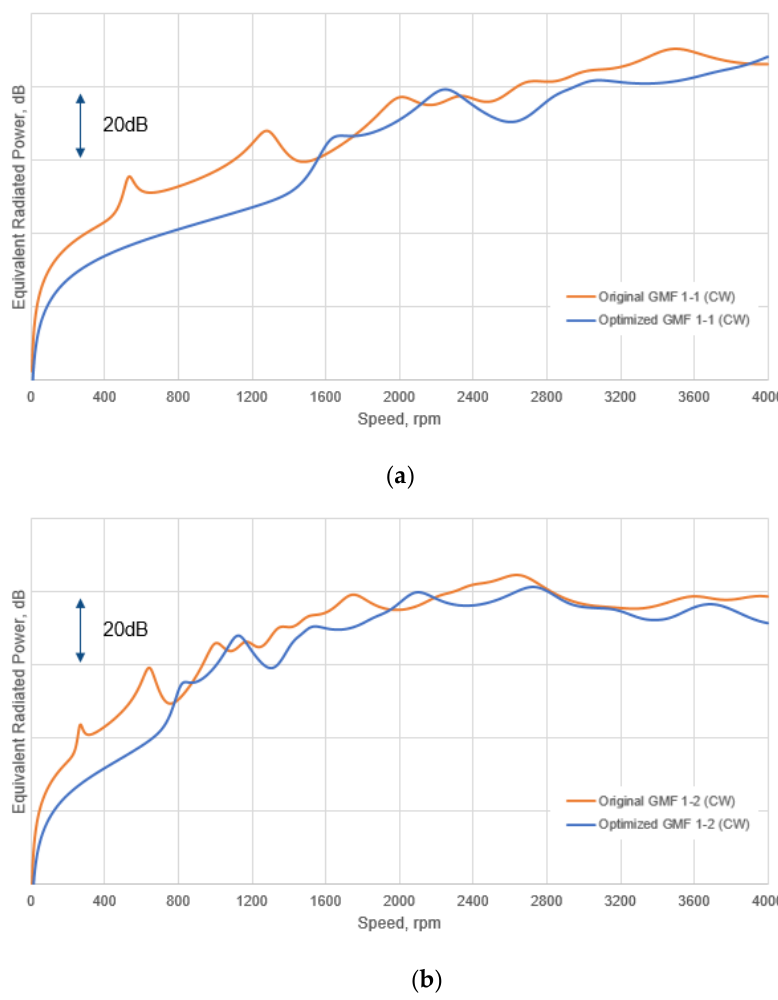
Figure 18. Equivalent radiated power (ERP) comparison for clockwise drive. ( a ): ERP excited by gear mesh stage 1-first harmonic; ( b ): ERP excited by gear mesh stage 1-second harmonic.